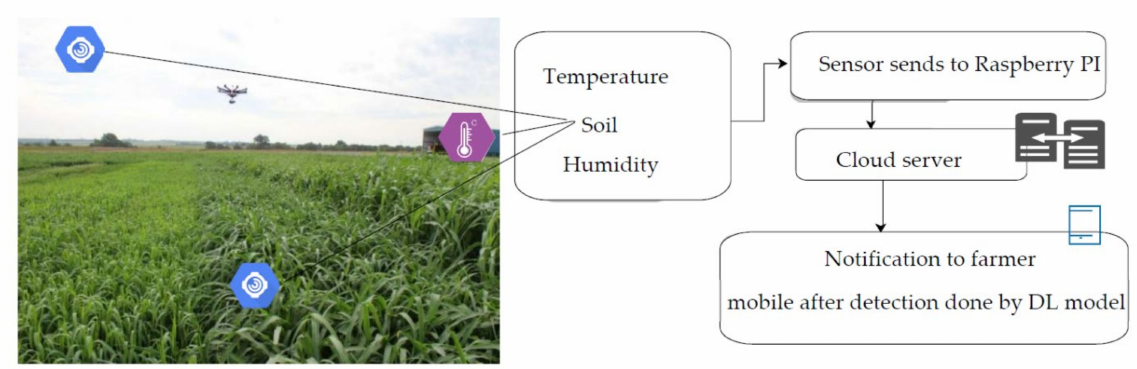
Figure 2. Role of sensors in the pearl millet farmland.